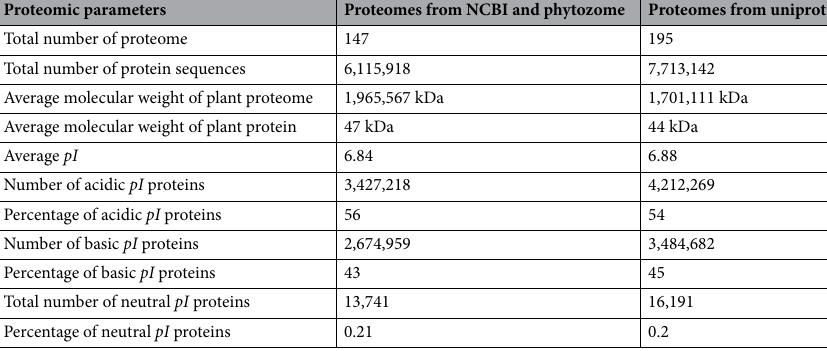
Table 1. Statistics of plant proteomes downloaded from different